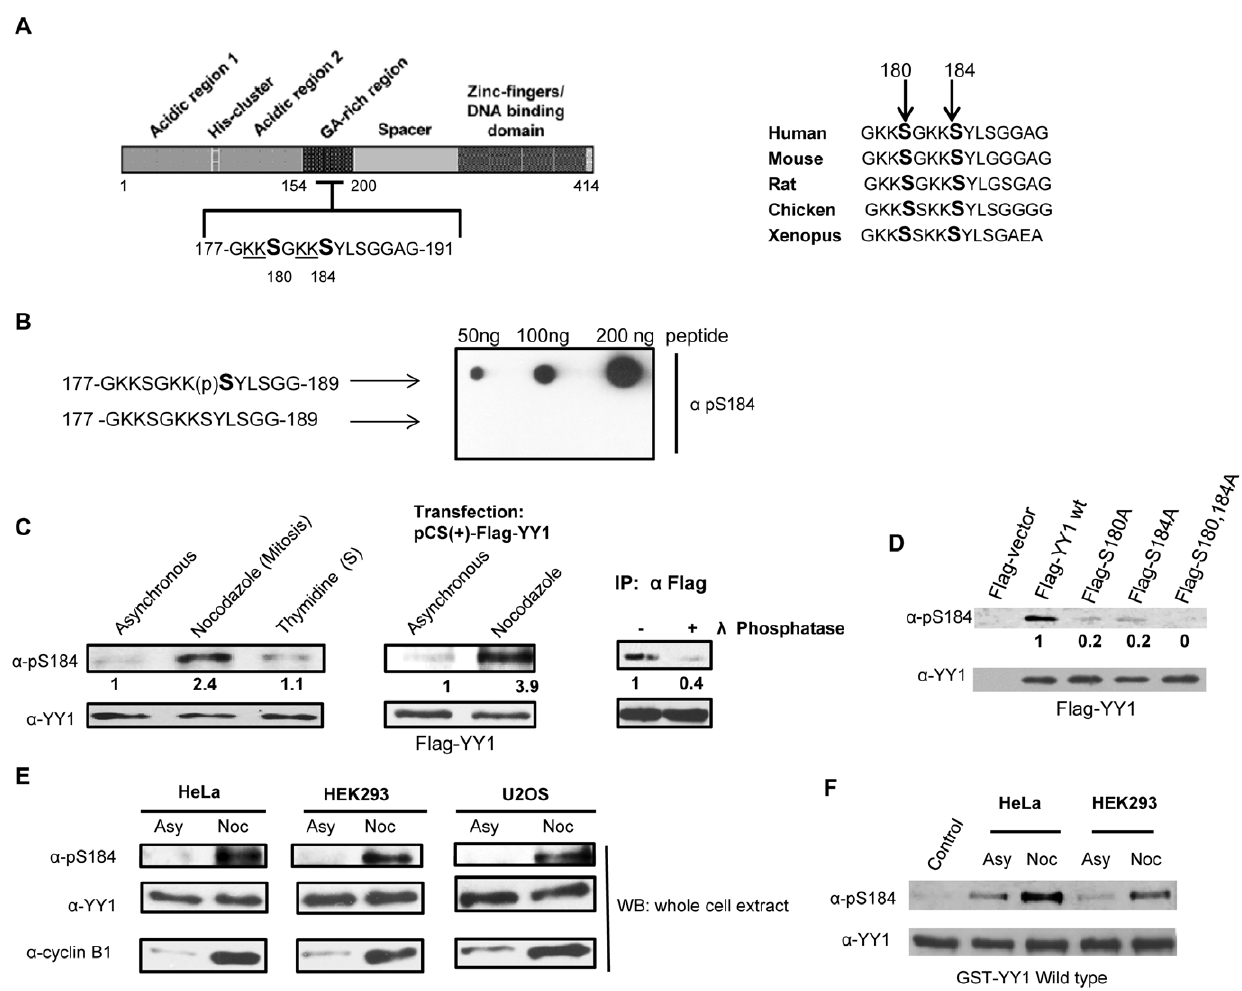
Figure 1. Phosphorylation of YY1 in nocodazole blocked extracts is detected by anti-phospho-S184 antibody. ( A ) Diagram showing the different domains of the YY1 protein. Amino acid residues 177–191 are shown, which include serine 180 and 184, as indicated (left panel). Amino acid sequence alignment of residues 177–191 of human YY1 from different animal species, as indicated (right panel). ( B ) Dot blot assay of non- phosphorylated and serine 184 phosphorylated synthetic peptides of YY1 amino acid sequence 177 to 189 probed with anti-pS184. ( C ) Asynchronous, nocodazole treated (100 ng/ml for 18 hours) and thymidine treated (2.5 mM for 18 hours) HEK293 cell lysates were prepared, followed by Western blot. The blot was probed with anti-pS184 antibody with relative levels indicated below, then stripped and reprobed with anti-YY1 antibody (left panel). Western blot analysis of asynchronous and nocodazole treated HEK293 cells transiently transfected with Flag-YY1, probed with anti-pS184 antibody with relative levels indicated below, then stripped and reprobed with anti-YY1 antibody (middle panel). Flag-YY1 was immunoprecipitated from transiently transfected HEK293 cells treated with nocodazole. Flag-YY1 bound to anti-Flag mouse MAb cross-linked to resin beads was resuspended in phosphatase buffer, and incubated with ( + ) or without (-) l -phosphatase at 30 u C for 30 minutes, followed by a Western blot of the samples. The blot was probed with anti-pS184 antibody with relative levels indicated below, then stripped and reprobed with anti-YY1 (right panel) ( D ) Western blot analysis of nocodazole treated HEK293 cells transiently transfected with Flag- vector, Flag-YY1 wild type, Flag-YY1 S180A, Flag-YY1 S184A and Flag-YY1 S180,184A was probed with anti-pS184 antibody with relative levels indicated below, then stripped and reprobed with anti-YY1 antibody. ( E ) Asynchronous and nocodazole treated (Asy or Noc) HeLa, HEK293 and U2OS cell lysates were prepared, followed by Western blot analysis. The blot was probed with anti-pS184 antibody, then stripped and reprobed with anti-YY1 antibody followed by anti-cyclin B1 antibody to show proper mitotic synchrony (left panel). ( F ) Cold in vitro kinase assay reactions using Hela and HEK293 whole cell extracts (50 m g) as the kinase source. Both asynchronous (Asy) and nocodazole treated (Noc) extracts were used. Bacterially expressed GST-YY1 wild type bound to glutathione beads were used as substrate. The reactions were performed at 30 u C for 45 minutes followed by Western blot analysis. The blot was probed with anti-pS184 antibody, then stripped and reprobed with anti-YY1 antibody to show equal GST-YY1 levels.